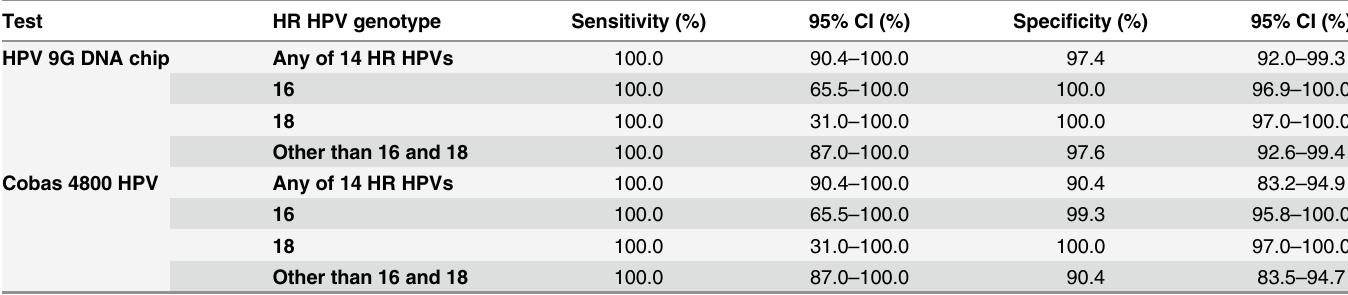
Table 2. Sensitivities and specificities of HPV detection tests for HR HPV